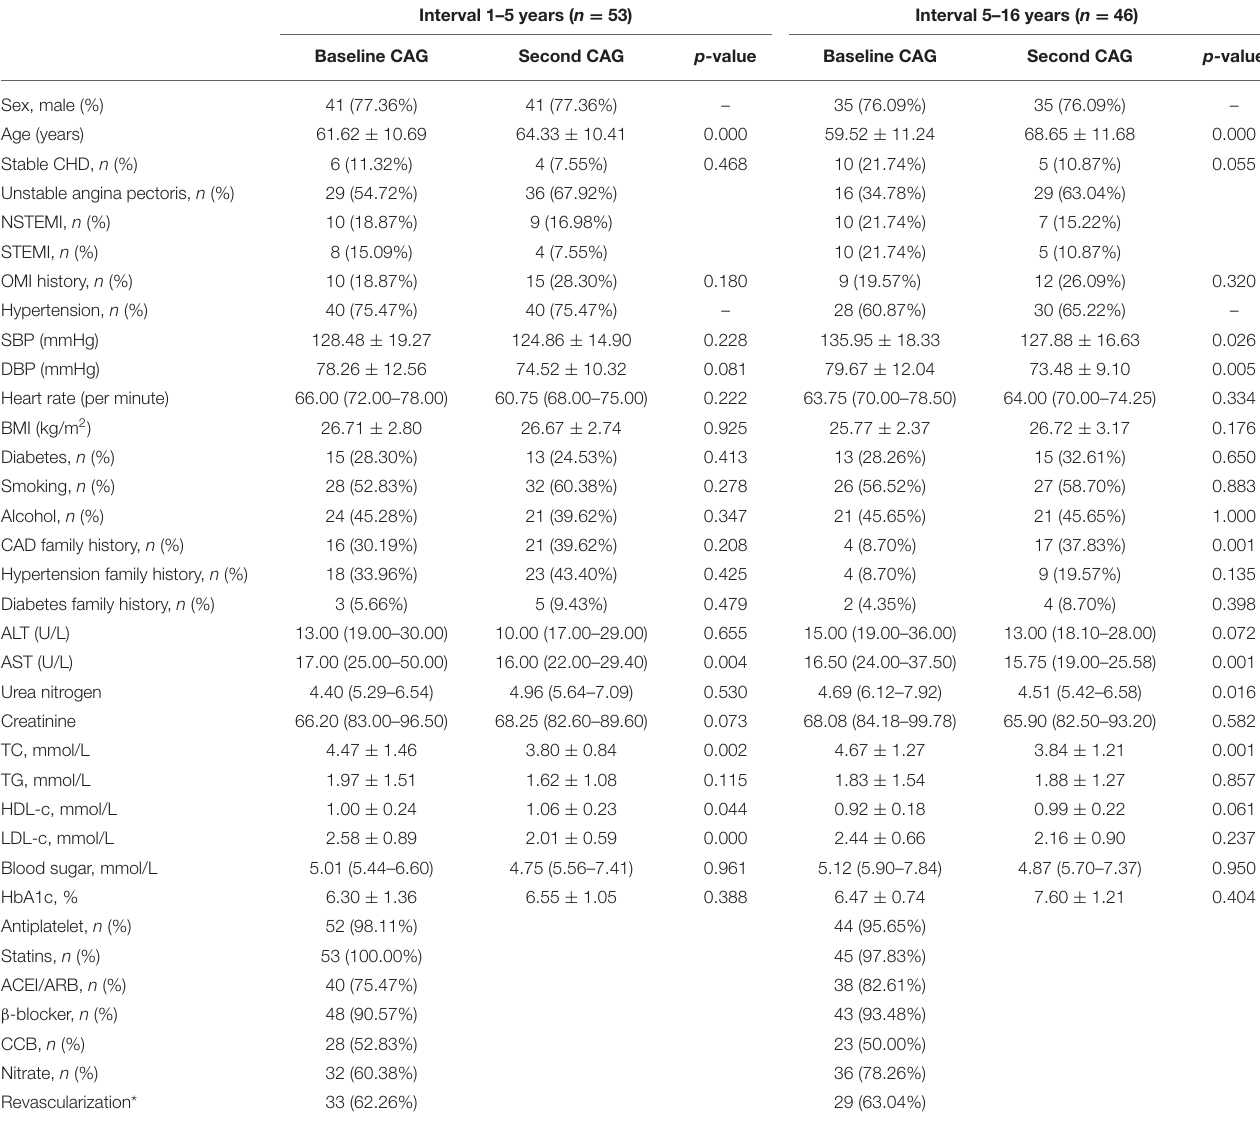
TABLE 1 | Baseline characteristics of coronary artery ectasia